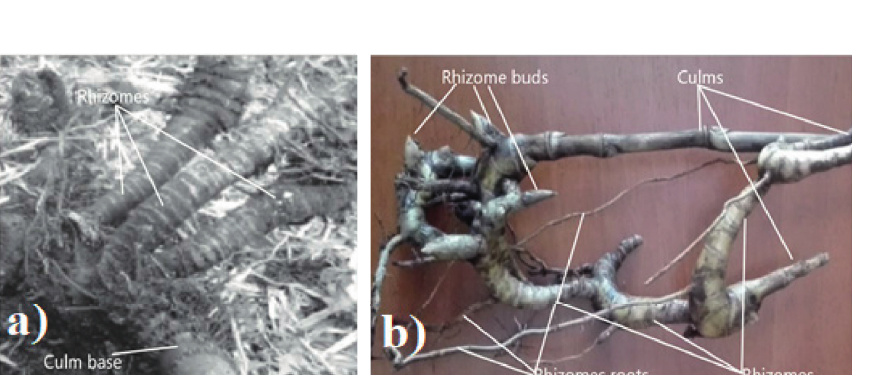
Figure 2: Rhizome type of (a) O. alpina (source: [37]) and (b) O. abyssinica. Clumps and culms: it is characterized by erect, thick-walled, and hollow culm bamboo species (Figures 3(a) and